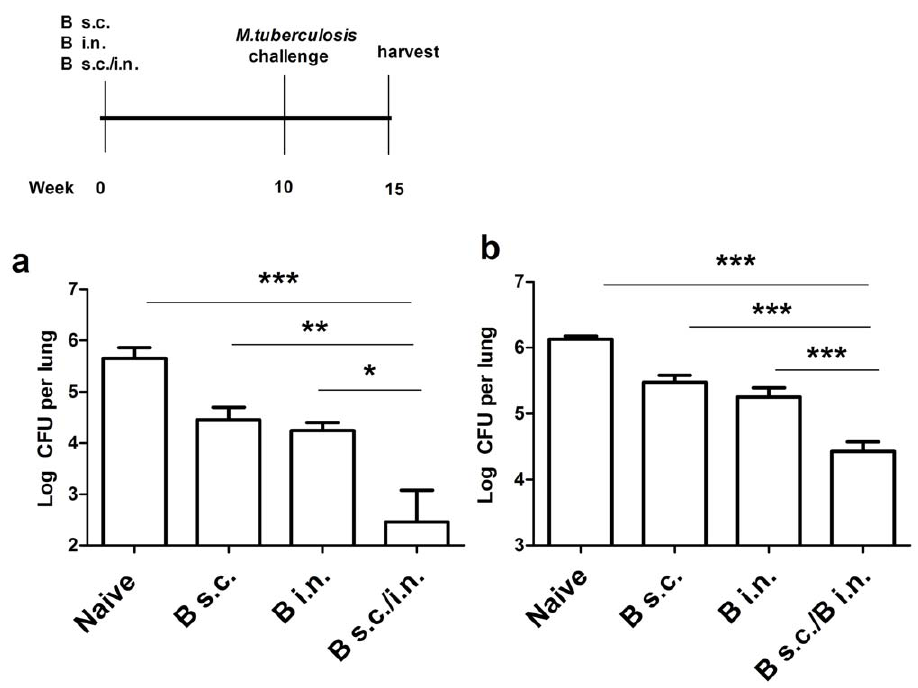
Figure 3. Mtb cfu after SIM with BCG. a and b. In two experiments, C57BL/6 mice were immunized once with BCG s.c. or BCG i.n. or simultaneously with the same dose of BCG divided between the s.c./i.n. routes. Ten weeks later they were challenged with Mtb and lung cfu enumerated 5 weeks later. Data from the two experiments with 5–7 mice/group are shown. ***p , 0.001, **p , 0.01, * p , 0.05 between the indicated groups, one-way ANOVA with Tukey’s post test. Data are means 6 s.e.m.